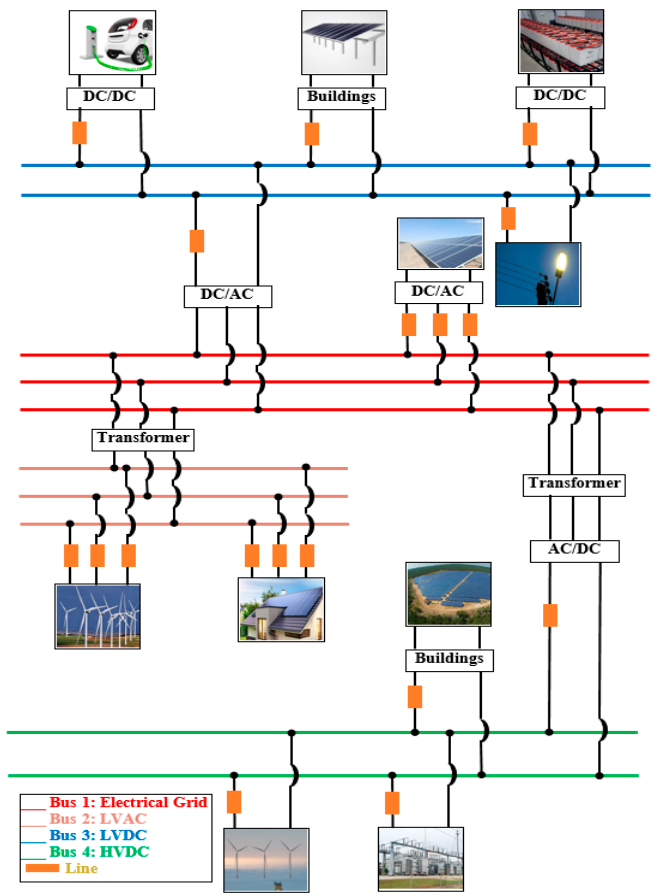
Figure 1. A multizone architecture zone design.